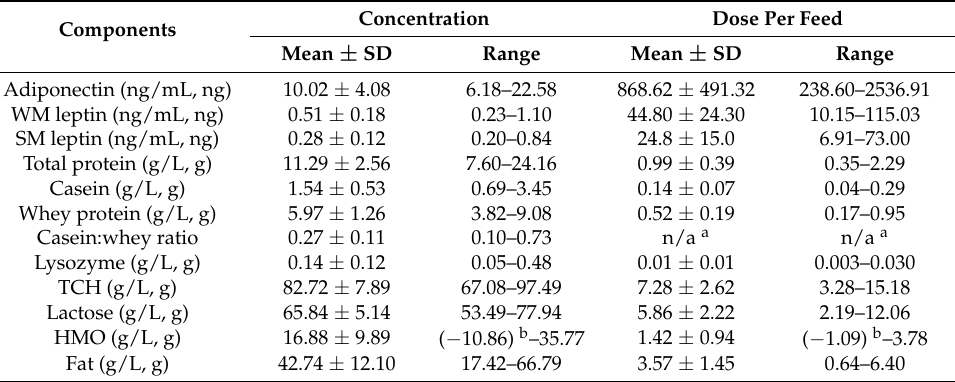
Table 2. Concentrations and doses of measured HM hormones and